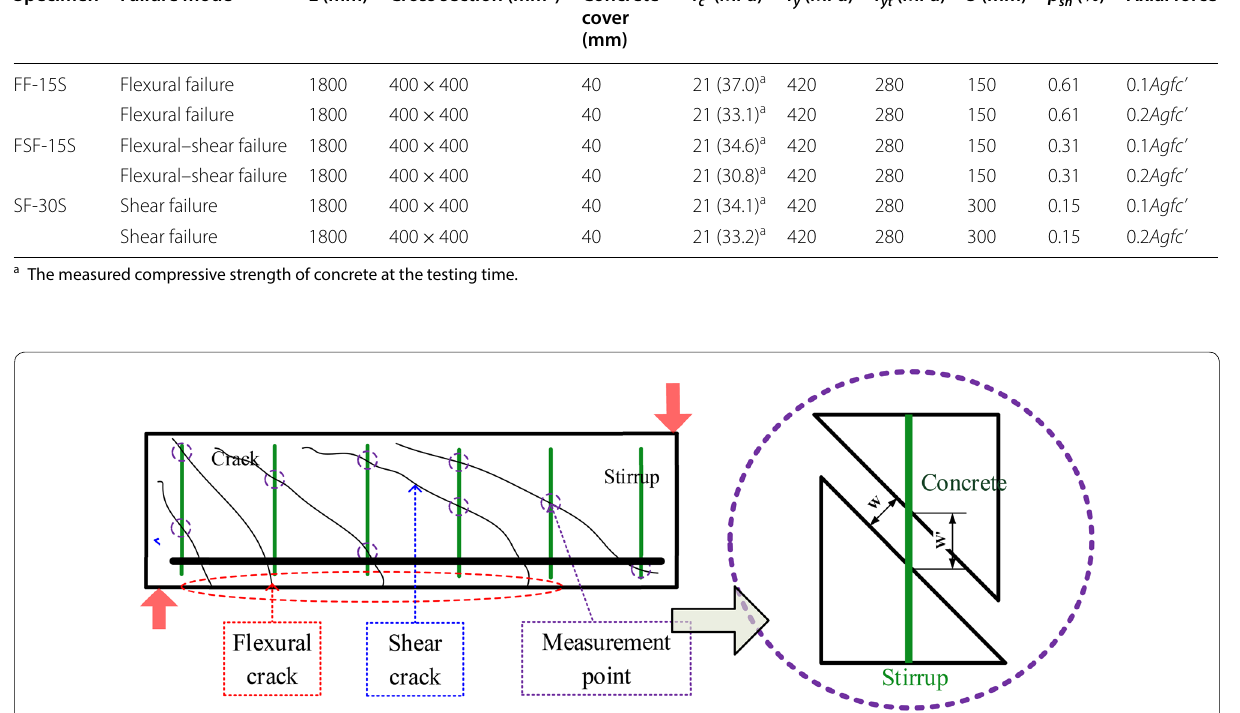
Table 5 Detailed information of each specimen.